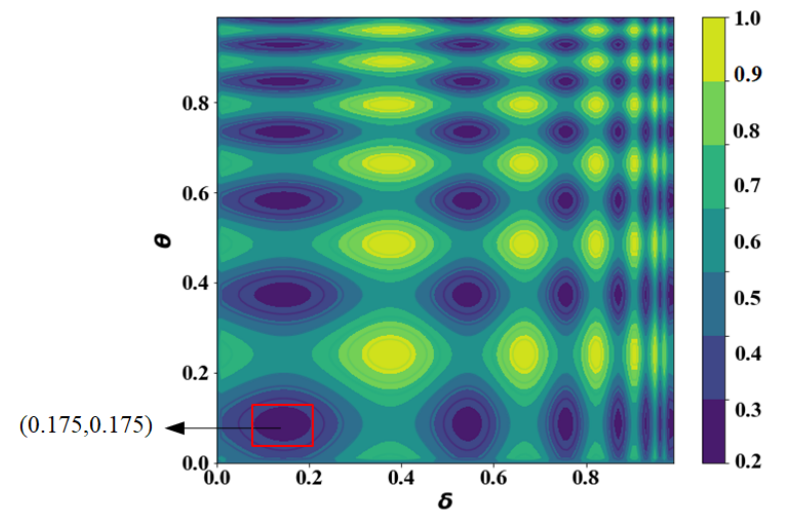
Figure 15. The determination of the ultimate optimum